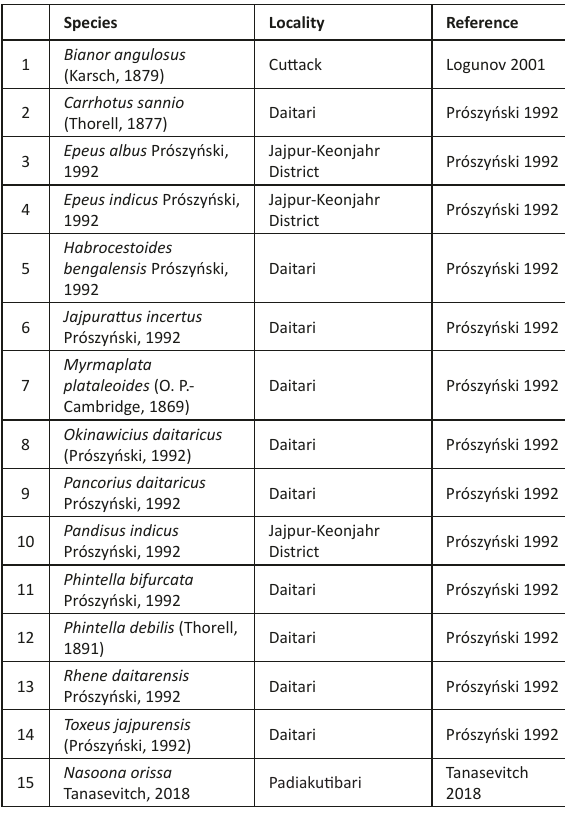
Table 1. Additions to the list of spider species known from Odisha State.